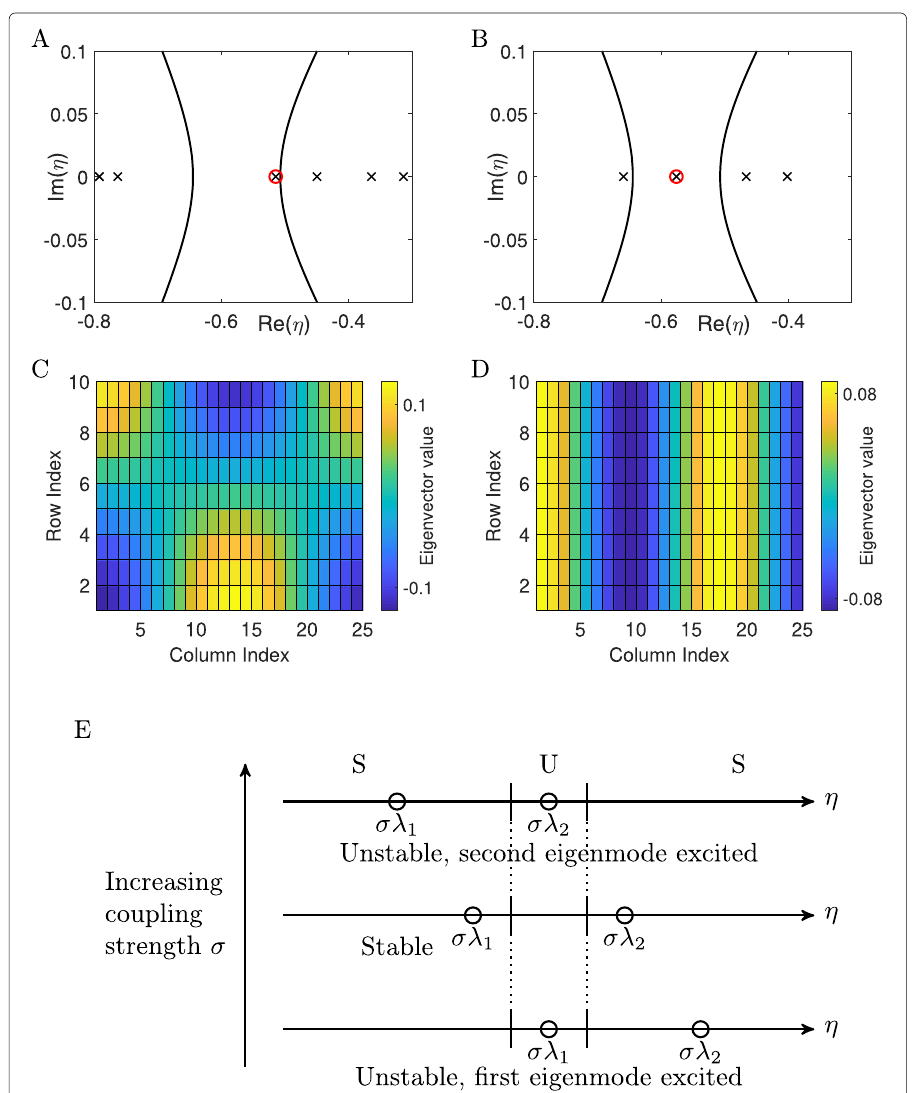
Fig. 6 a , b Zoom of the MSF for dominant luminal coupling around the the real axis with values of η = σλ k (crosses) superimposed for σ SR = 3.2 ( a ), σ SR = 4.1 ( b ) in a 10 × 25 network of CRUs paced at T p = 1.05. The value of η for which the MSF is positive is circled in red. ( c , d ) Eigenvectors corresponding to the critical values of η in ( a ) and ( b ), respectively. e Schematic of how changing the coupling strength σ can give rise to different patterns of the network activity. See text for